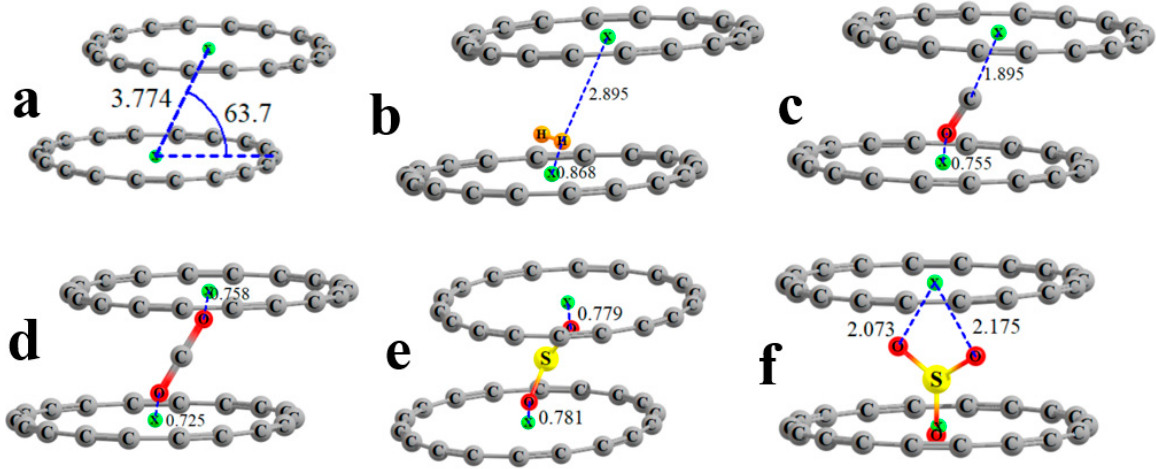
Figure 4. Geometries of double ring systems with ligands: ( a ) none, ( b ) H 2 , ( c ) CO, ( d ) CO 2 , ( e ) SO 2 , and ( f ) SO 3 . Green spheres indicate center of each ring, distances in Å. Table 5. Interaction, binding, and deformation energies (kcal/mol) of C 18 ∙∙∙ L ∙∙∙ C 18 inclusion com- plexes calculated at the ω B97XD/Def2TZVPP level of theory. In addition, also listed as d (Å) is the distance between ring planes.